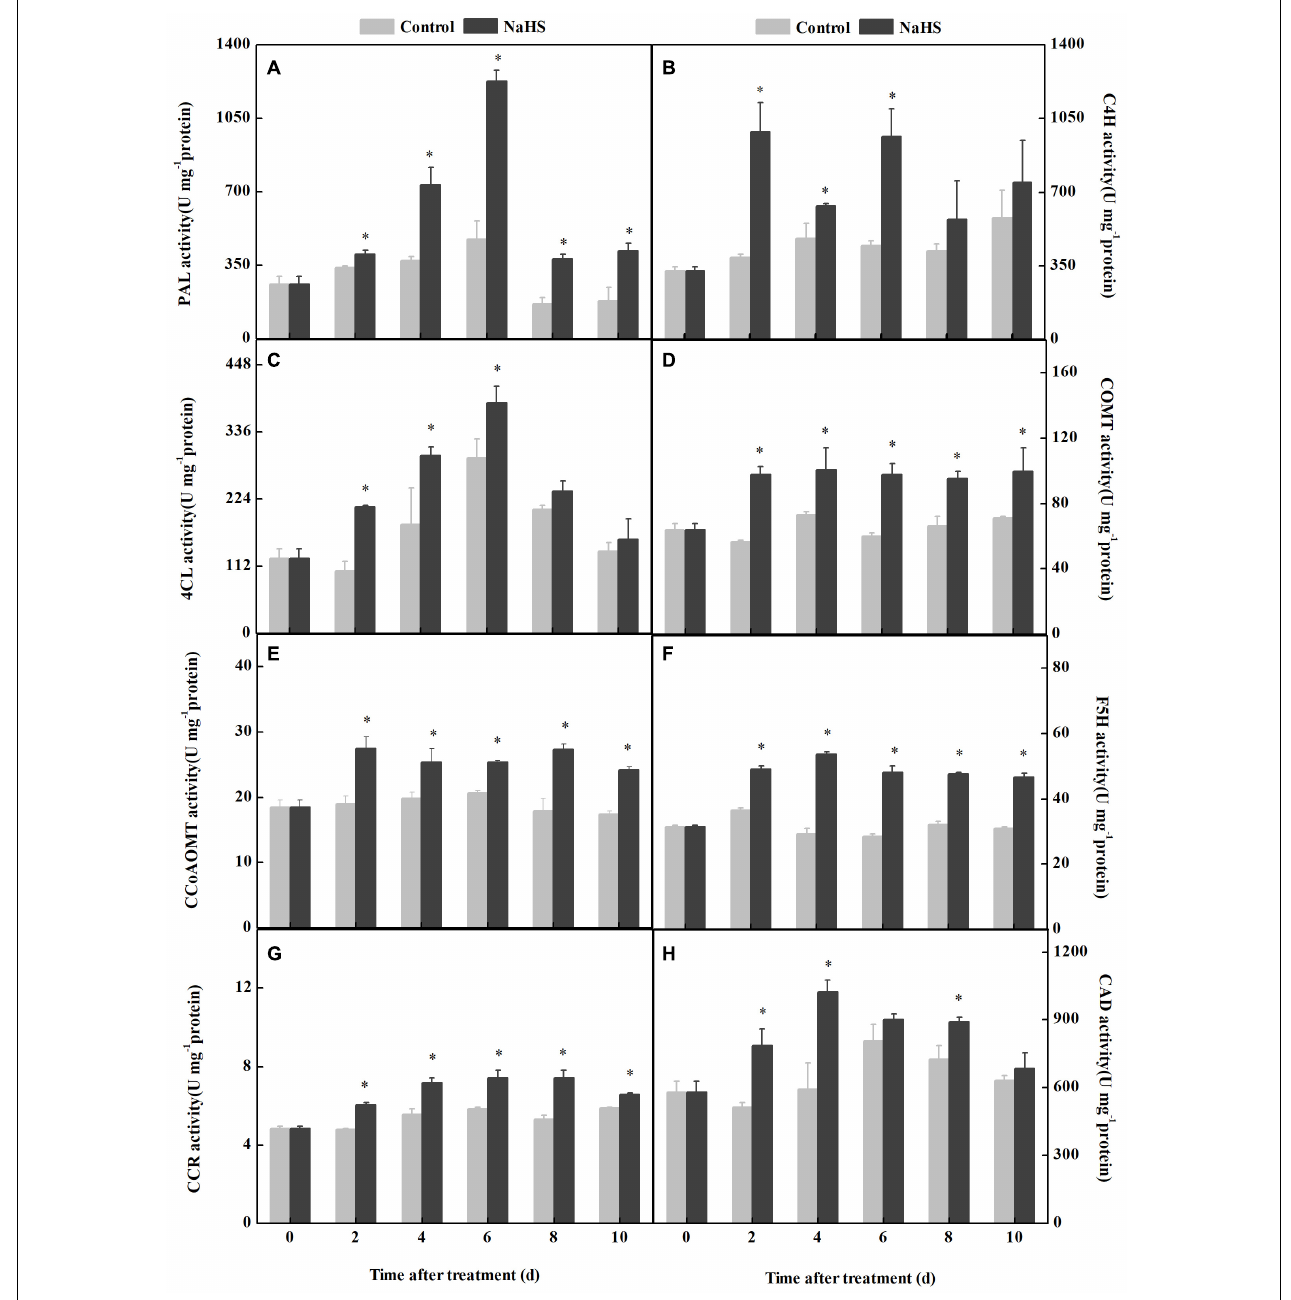
FIGURE 3 | Changes in the activity of the key enzyme of the phenylpropanoid pathway in apples after NaHS treatment. PAL (A) , C4H (B) , 4CL (C) , COMT (D) , CCoAOMT (E) , F5H (F) , CCR (G) , and CAD (H) . The light gray and black bars represent the control and NaHS treatments, respectively. The bars represent the standard error of the mean ( ± SE). ∗ Significant differences at P <